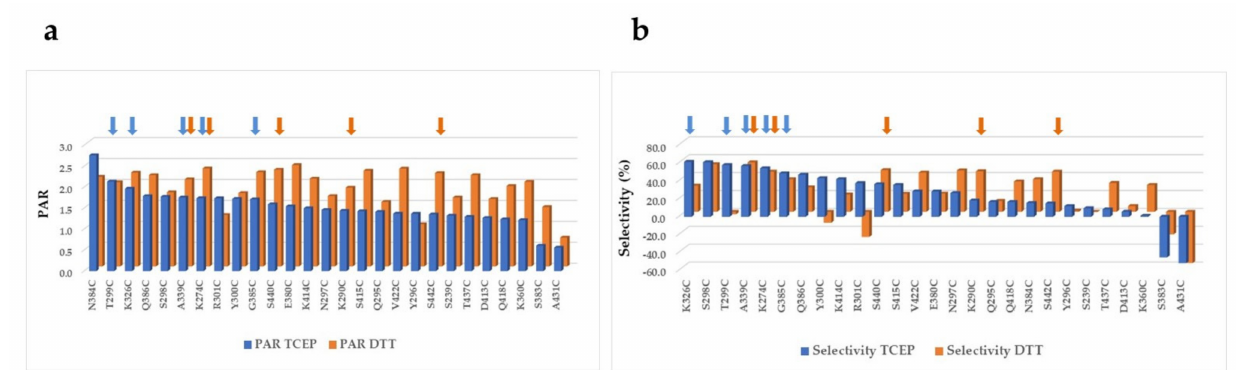
Figure 5. Comparison of conjugation efficiency ( a ) and selectivity ( b ) of single cysteine mutants PEGylated after DTT and TCEP partial reduction. The single unpaired cysteine mutants were partially reduced with either DTT or TCEP to uncap the engineered cysteine residues. After being re-oxidized, the antibody samples were PEGylated and analyzed for conjugation efficiency and selectivity as described in Methods. Selectivity = % mono-PEG% un-PEG—% multi-PEG. The arrows in orange represent the top five mutants identified by conjugation with DTT, while the arrows in blue show the top five mutants identified by conjugation with